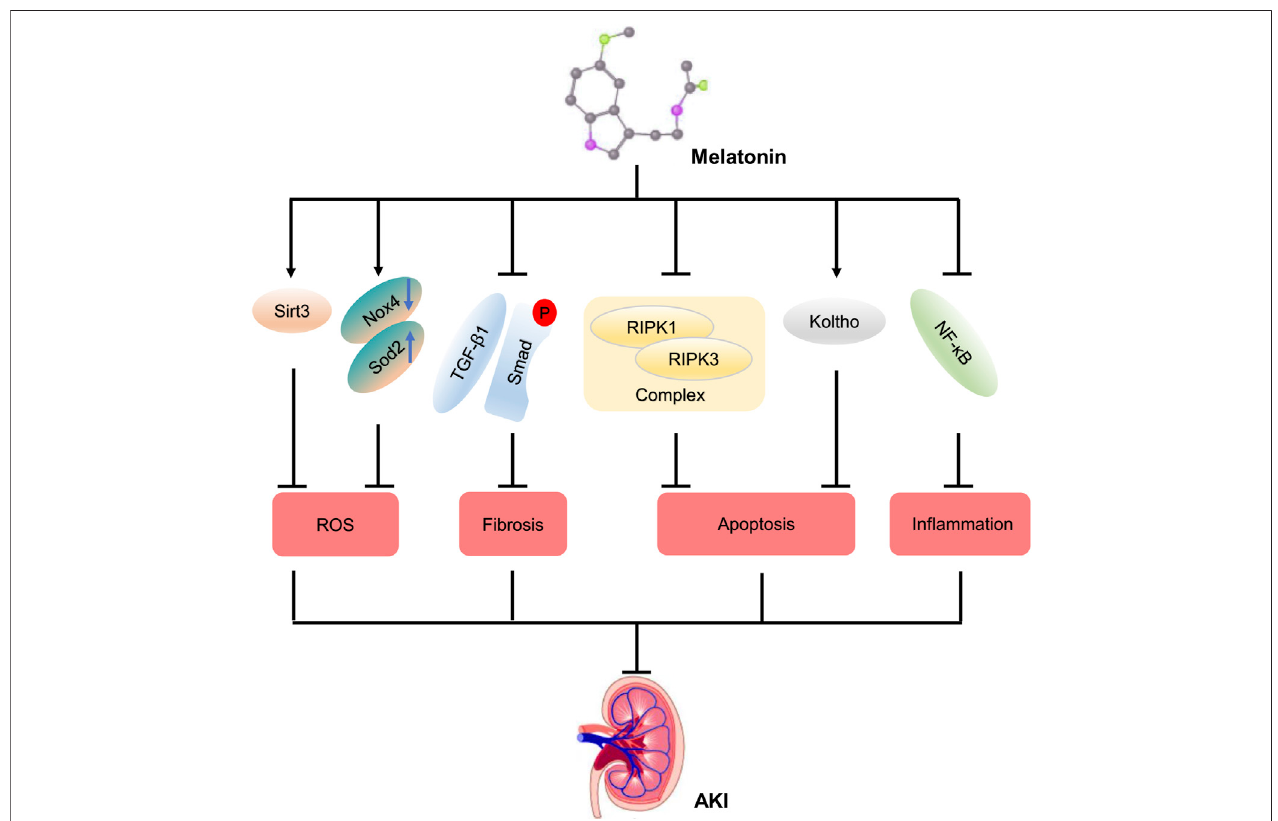
FIGURE 6 | Potential protective mechanism of melatonin on AKI. A diagrammatic representation of some of the protective mechanism of melatonin on AKI. Abbreviations: Sirt3, Sirtuin-3; TGF- β 1, transforming growth factor- β 1; RIPK, receptor-interacting protein kinase; NF- κ B, nuclear factor kappa-B; ROS, reactive oxygen species; AKI, acute kidney